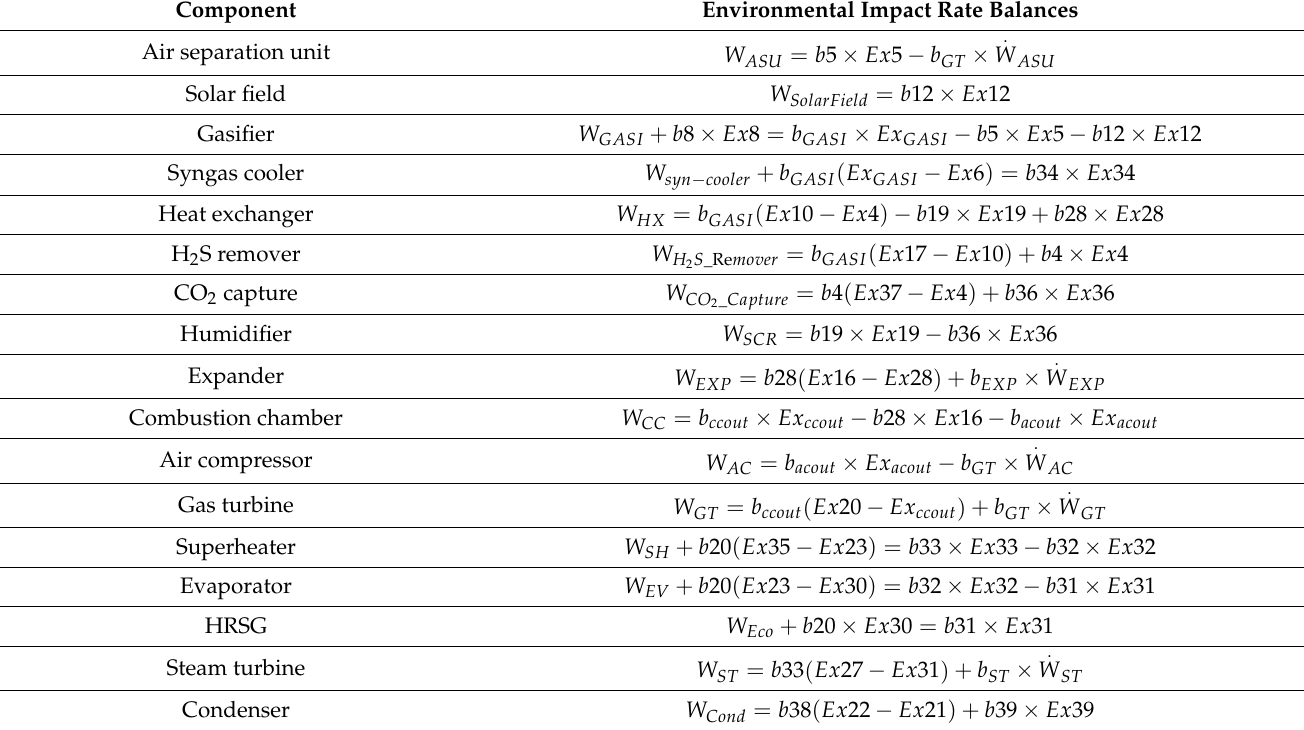
Table A6. Environmental impact rate formulation for the different ISGC system components